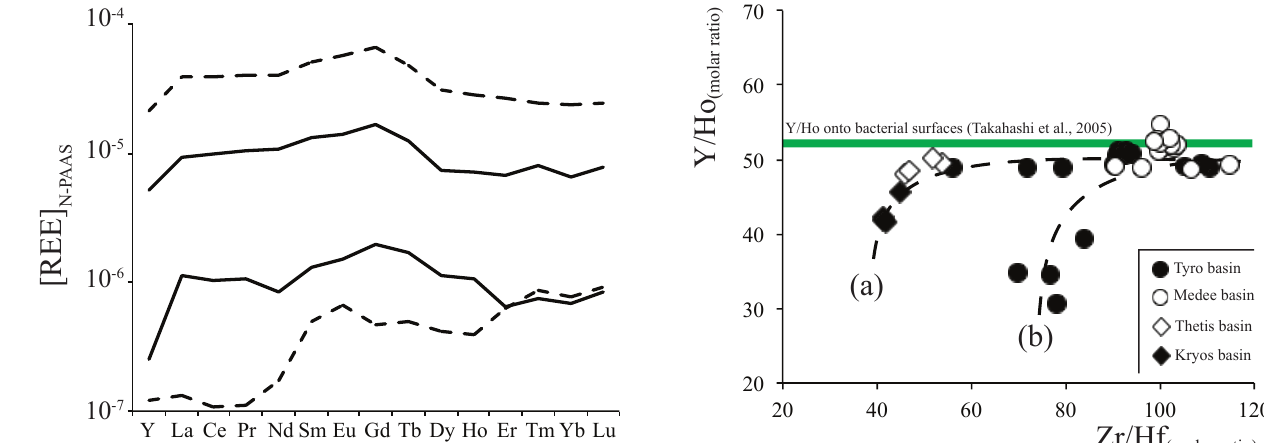
Fig. 8. Y/Ho vs. Zr/Hf behaviour. (a) and (b) : trends represent hy- Figure 8 – Y/Ho vs. Zr/Hf behaviour. (a) and (b) trends represent hypothetical mixing arrays as 642 pothetical mixing arrays as detailed in the text. The range of Y/Ho detailed in the text. The range of Y/Ho values measured onto bacterial surfaces by Takahashi et al. 643 values measured onto bacterial surfaces by Takahashi et al. (2005) is reported for (2005) is reported for reference. 644